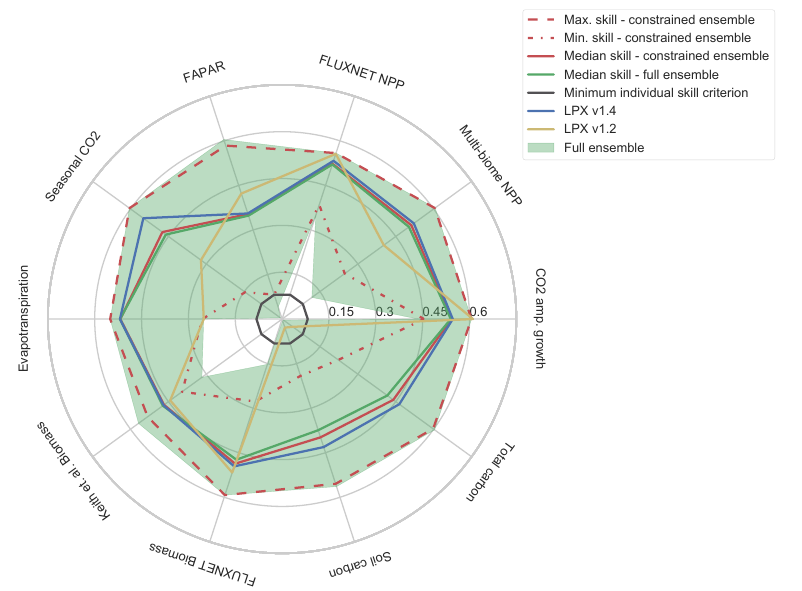
1 2 MSE rel for the M net , net